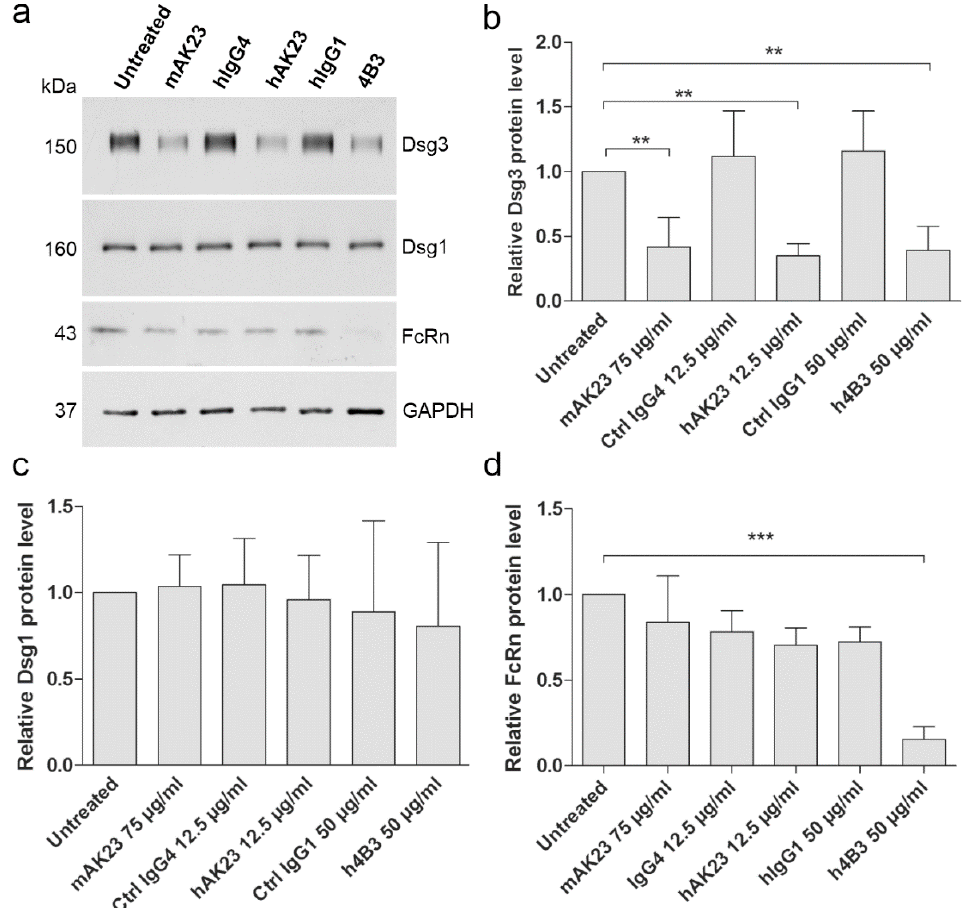
Figure 3. Treatment of keratinocytes with hAK23 and 4B3 antibodies results in Dsg3 depletion, and 4B3 abrogates FcRn protein level. ( a ) hTert cells were plated on 6-well plates, grown in KGM2 medium with 0.05 mM CaCl 2 until confluent, and then switched to KGM2 with 2 mM CaCl 2 for 24 h. Thereafter, the cells were treated for 24 h with the recombinant antibodies hAK23 (12.5 µ g/mL) or 4B3 (50 µ g/mL). As controls, mock incubation (untreated), an isotype-matched hIgG (12.5 µ g/mL IgG4, or 50 µ g/mL hIgG1), and mAK23 (75 µ g/mL) were used. The cells were lysed, and the level of Dsg3, Dsg1 and FcRn was analyzed by Western blot. GAPDH was included as a loading control. A representative experiment is shown. ( b – d ) Western blot signals were quantified using ImageJ software, normalized against GAPDH, and expressed as relative values compared to the untreated control. The error bars represent the SD of values obtained from four independent